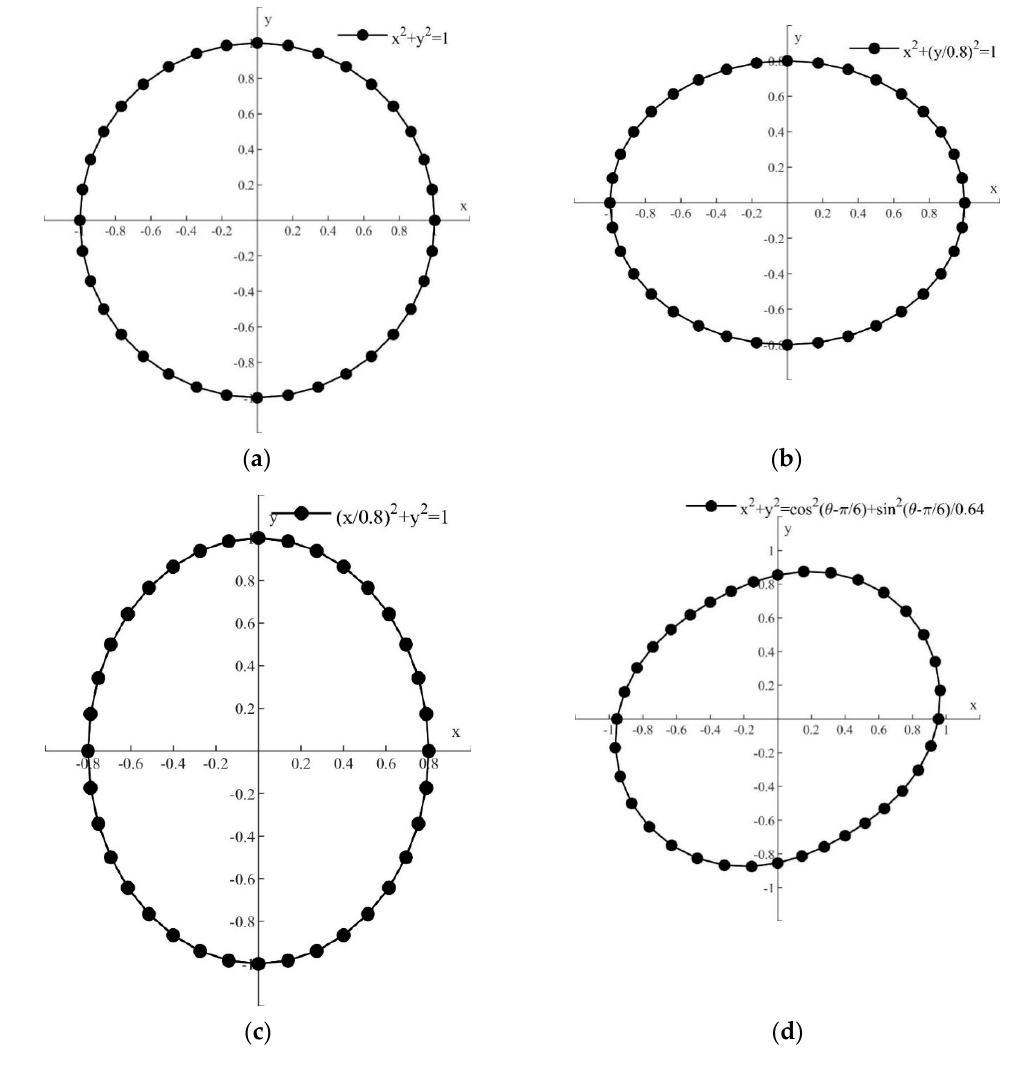
Figure 2. Fitting sample distributions for ( a ) TD1, ( b ) TD2, ( c ) TD3, and ( d ) TD4.